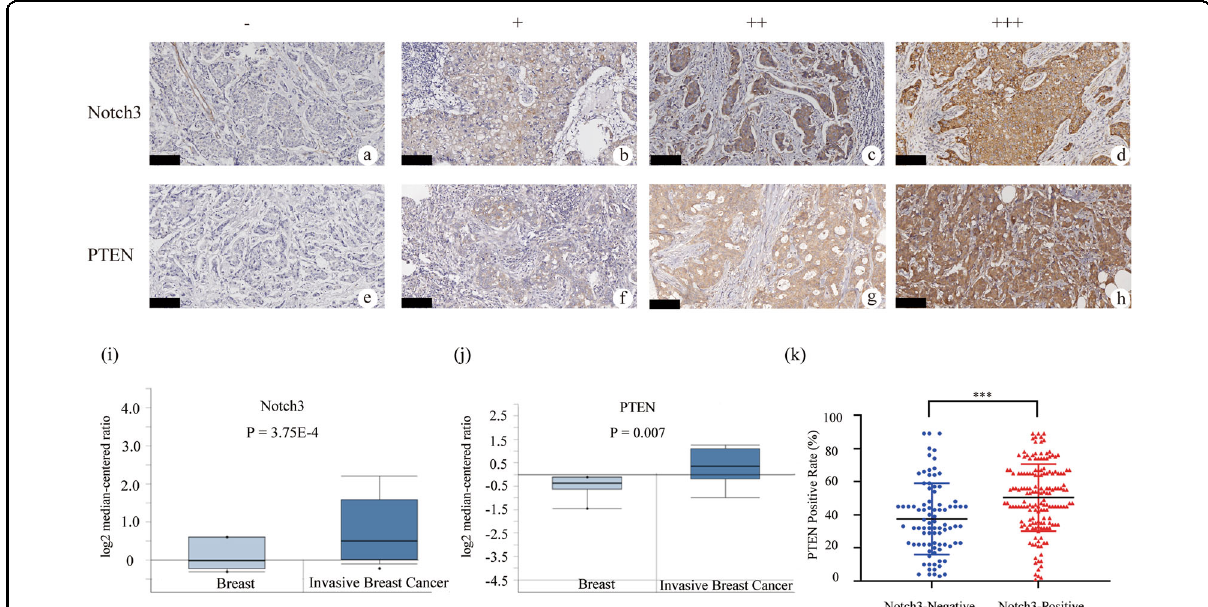
Fig. 5 Notch3 expression is associated with PTEN in clinical breast cancer specimens. a Representative image of Notch3-negative ( − ) ( b ) Notch3-weak positive ( + ) ( c ) Notch3-medium positive ( ++ ) ( d ) Notch3-strong positive ( +++ ) ( e ) Representative image of PTEN-negative ( − ) ( f ) PTEN-weak positive ( + ) ( g ) PTEN-medium positive ( ++ ) ( h ) PTEN-strong positive ( +++ ) specimens, original magni fi cation, 400x. Comparison of the mRNA level of ( i ) Notch3 and ( j ) PTEN in Finak Breast dataset by ONCOMINE analysis. k The positive correlation between Notch3 and PTEN expression was determined using the two-sided t -test. The scale bar for 100 μ m. *** P <